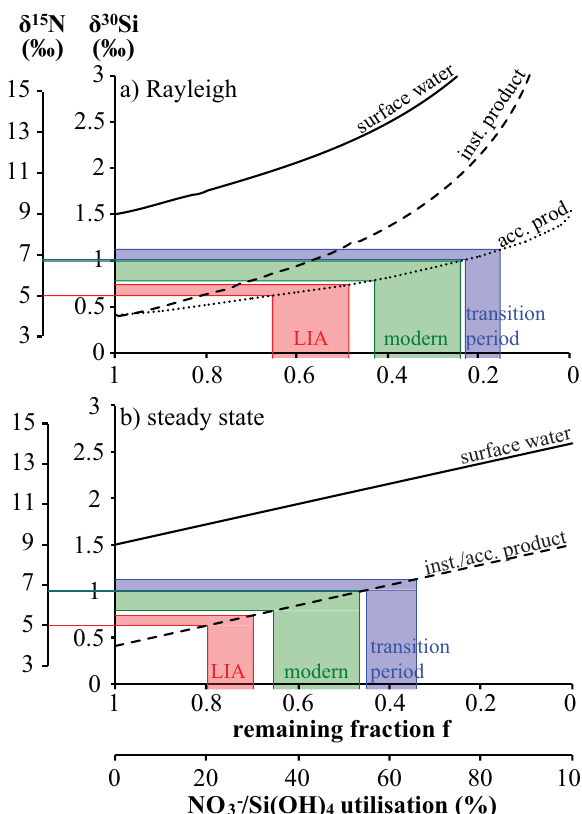
Figure 5. Theoretical changes in δ 30 Si and δ 15 N values of seawater and the instantaneous and accumulated prod- uct as a function of f (remaining nutrients from the avail- able pool = [nutrient observed ]/[nutrient initial ]) with an initial δ 30 Si Si ( OH ) 4 value of + 1.5‰ and δ 15 N of + 9‰. The forma- NO − 3 tion of the product, e.g. diatom opal, follows either (a) Rayleigh- type fractionation or (b) steady-state-type fractionation behaviour, with enrichment factors ε of − 1.1‰ ( δ 30 Si) and − 5‰ ( δ 15 N) (cor- responding to conditions along the modern central Peruvian shelf; see Fig. 4). The colour shadings mark the range of measured mean δ 30 Si opal (both cores) and δ 15 N sed (B0405-6 only) in the cores for the LIA (red), the transition period (blue) and modern sediments (green), from which the respective nutrient utilisation (%) can be